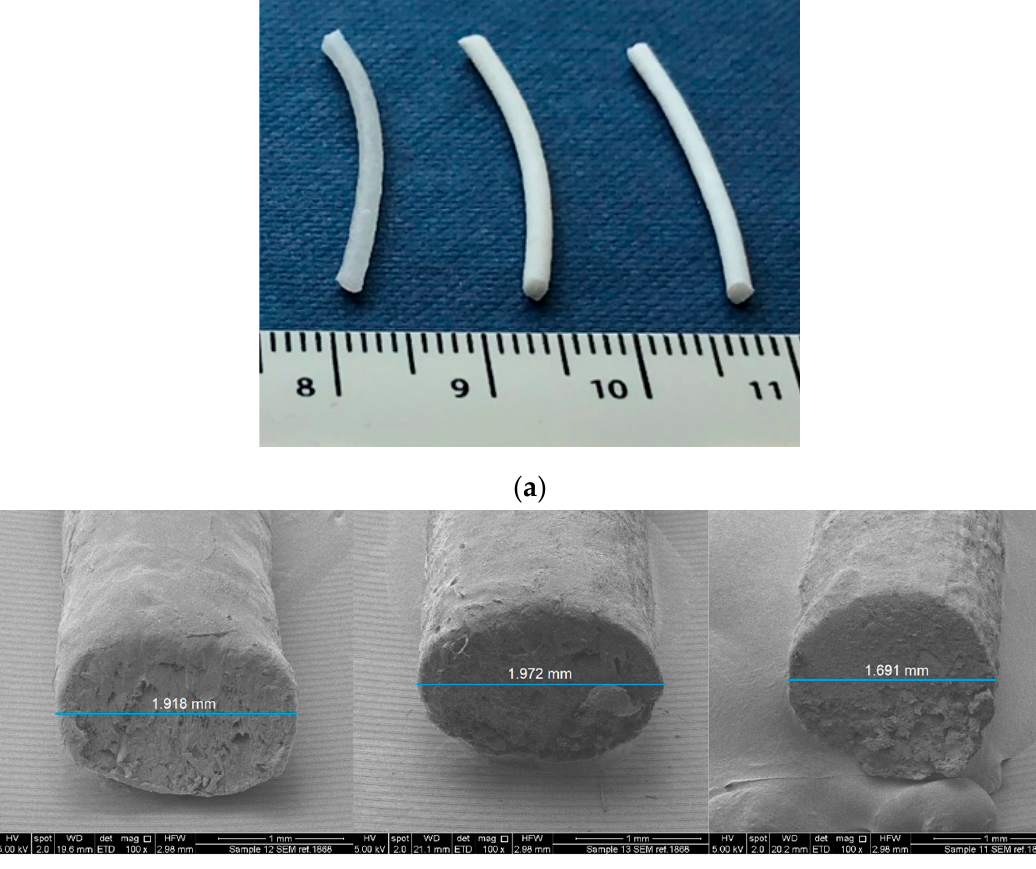
Figure 2. ( a ) Picture and ( b ) SEM images of core filaments with different drug loadings. From left to right: F10, F25, and F40.